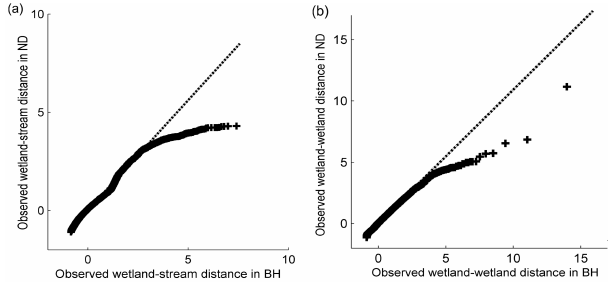
Figure 9. Quantile–quantile (Q–Q) plot comparing the distributions of observed shortest distances between surface water bodies in the Beaverhill watershed (BH) and prairie potholes in North Dakota (ND). (a) Standardized wetland–stream distance (observed short- est distances of wetland to nearest major stream) in the BH vs. standardized wetland–stream distance in prairie potholes in ND. (b) Standardized wetland–wetland distance (observed shortest dis- tances of wetlands to their nearest wetland neighbor) in the BH vs. standardized observed wetland–wetland distance in prairie potholes in